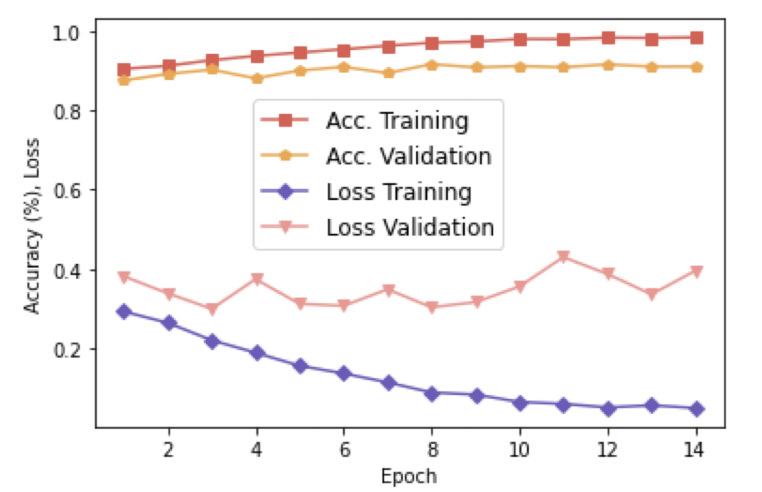
Figure 5. Accuracy and loss: training and validation.